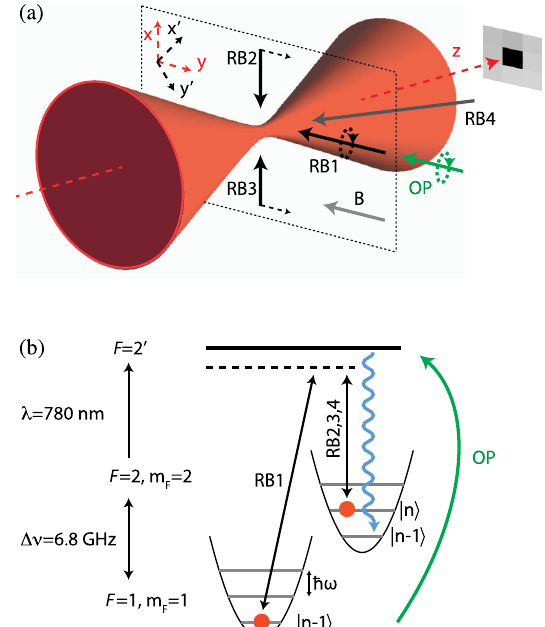
FIG. 1. Experimental setup for tweezer trap, detection, and three-dimensional motional control. (a) An optical tweezer cre- ated with a high-NA objective lens traps a single neutral atom, and the atom is imaged along the z axis with the same lens. Orthogonal radial axes, indicated by x 0 and y 0 , are addressed by Raman beam 1 (RB1) ( (cid:3) þ polarized) and RB2 ( (cid:2) polarized), or RB1 and RB3 ( (cid:2) polarized). RB1 and RB4 (linearly polarized in the y - z plane) address the axial direction. Note that we should be able to cool vibrational motion along all three axes with a single pair of counterpropagating beams. (b) Level diagram for 87 Rb with associated beams from (a). The Raman light is 50 GHz red, detuned of the excited state manifold. Optical pumping (OP) consists of the repump light on the F ¼ 1 ! 2 0 transition along with the optical-pumping light on F ¼ 2 ! 2 0